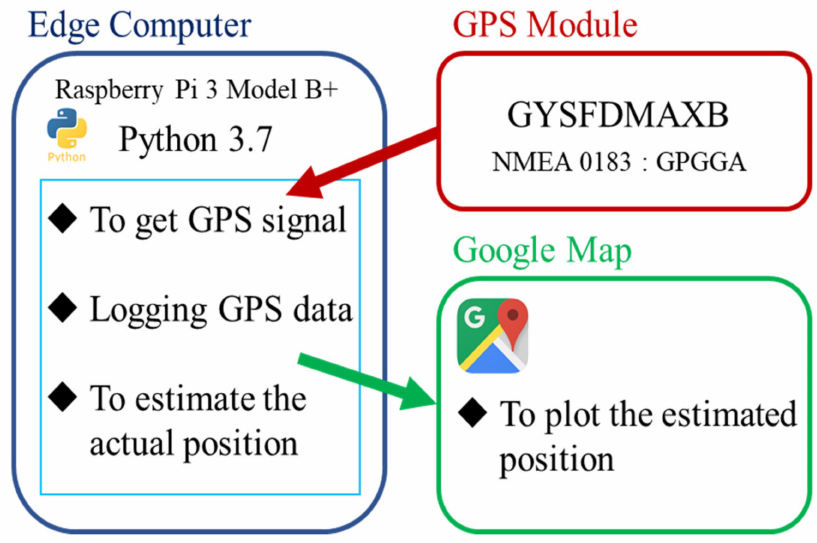
Figure 5. A schematic illustration of our